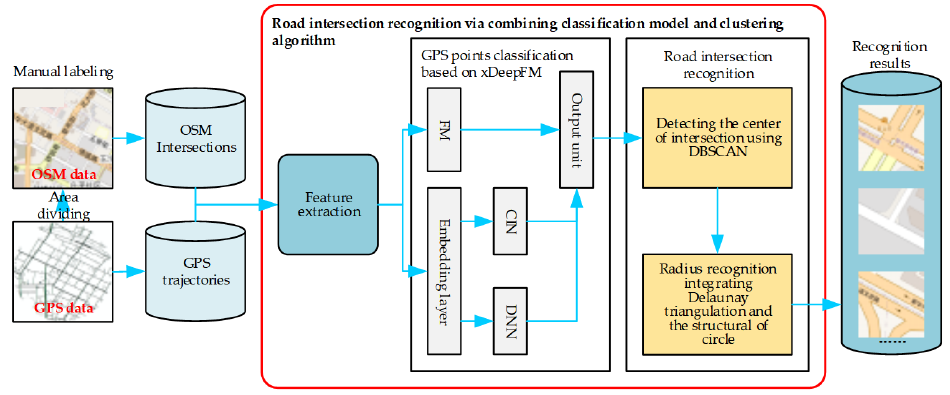
Figure 1. The framework of the proposed method.